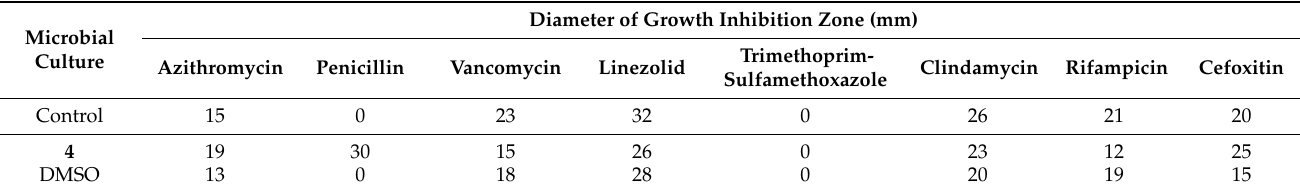
Table 3. Antibiotic susceptibility testing of the S. aureus ATCC 6538 strain cultivated in the presence of DMSO and of sub-inhibitory concentrations of compound 4 .